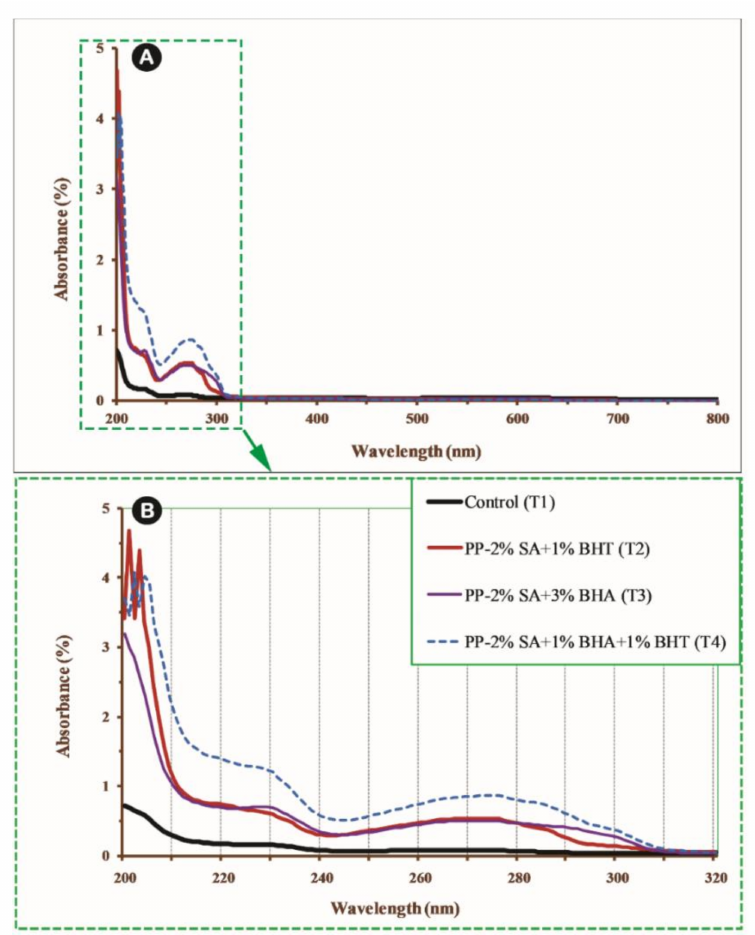
Figure 7. Effect of different composition of additives on UV absorbance of PP-based active films at wavelength range of 200–800 nm ( A ); the same results at wavelength range of 200–320 nm ( B